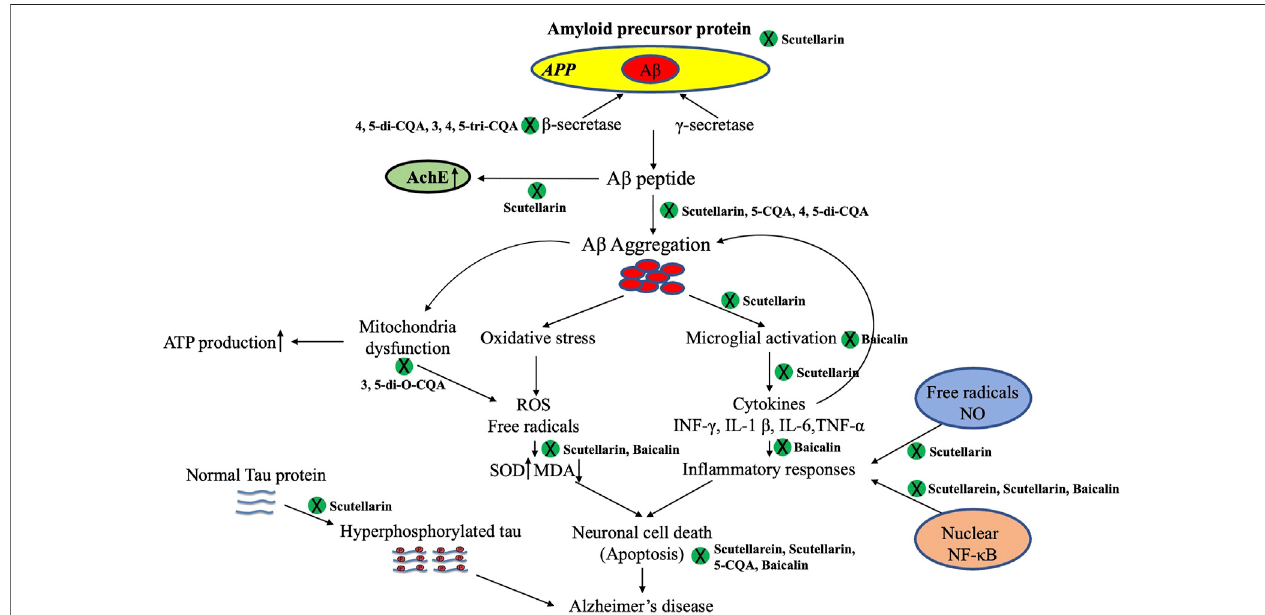
FIGURE 3 | Different active constituents of Erigeron breviscapus (Vant.) Hand-Mazz. have shown anti-AD effects against A β deposition, hyperphosphorylated Tau protein, cholinergic neurotransmitters, neural apoptosis, oxidative stress, and neuroin fl ammation. 5-CQA, 5-O-caffeoylquinic acid; 4, 5-di-CQA, 4, 5-dicaffeoylquinic acid;3,4,5-tri-CQA, 3,4,5-tricaffeoylquinicacid;AD,Alzheimer ’ sDisease;ATP,adenosinetriphosphate;MDA,malondialdehyde;ROS,reactiveoxygenspecies;SOD, superoxide